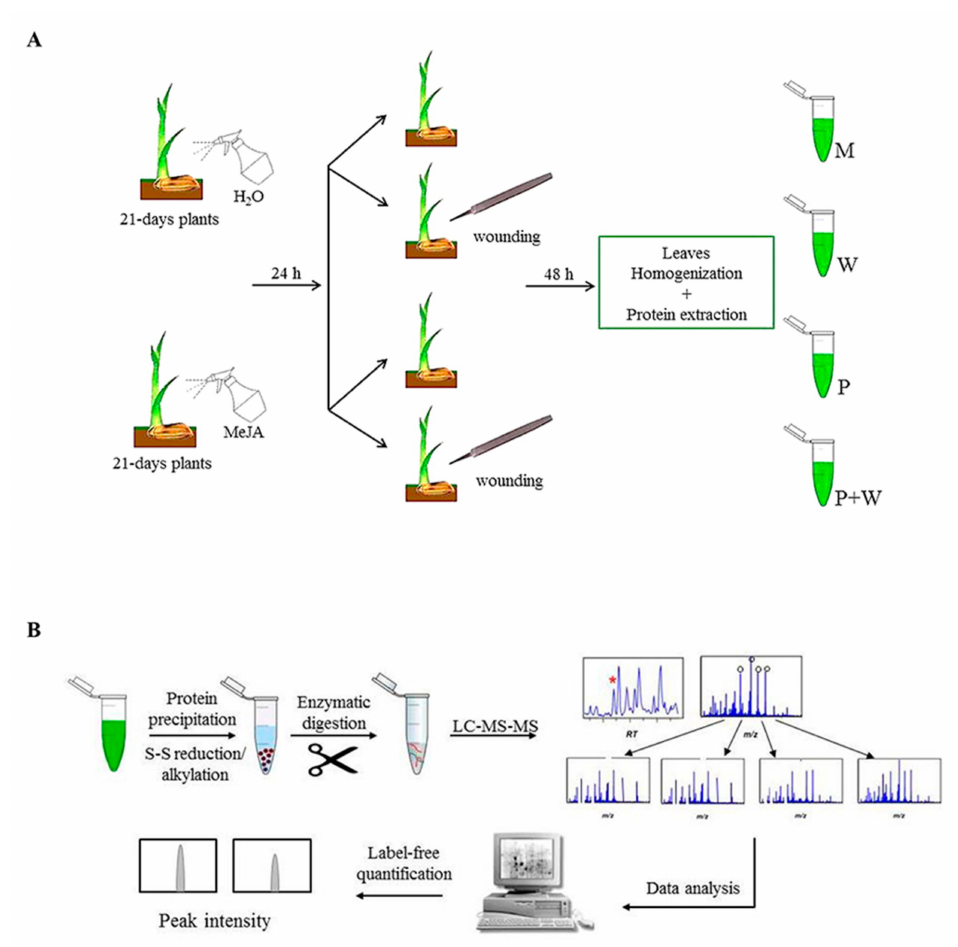
Figure 1. Experimental workflow. ( A ) Plant treatments. Mock (M), leaves after wounding (W), leaves primed with MeJA (P), and leaves primed with MeJA followed by wounding (P + W). ( B ) Protein treatment and proteomic